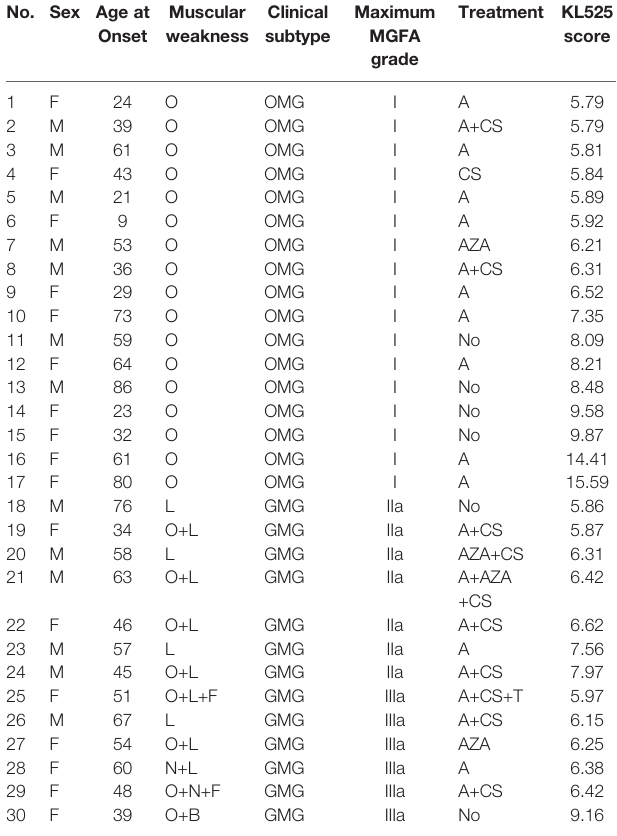
TABLE 2 | Clinical characteristics of sNMG patients with positive anti-AChR antibodies detected by the KL525 CBA. No. Sex Age at Muscular Clinical Maximum Onset weakness subtype